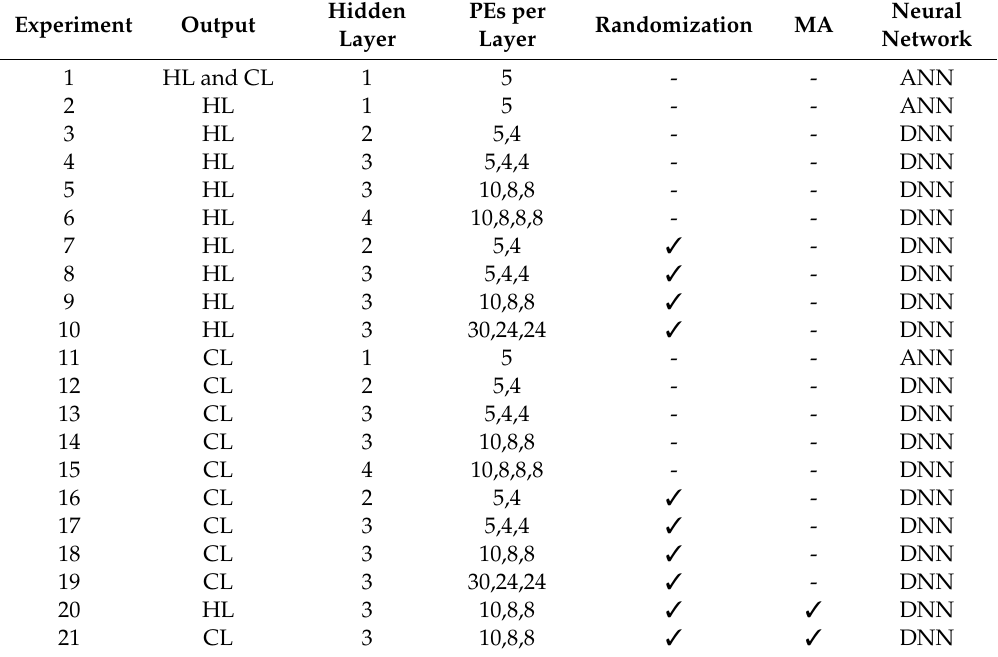
Table 3. Characteristics of experimental models. “PEs” stand for processing